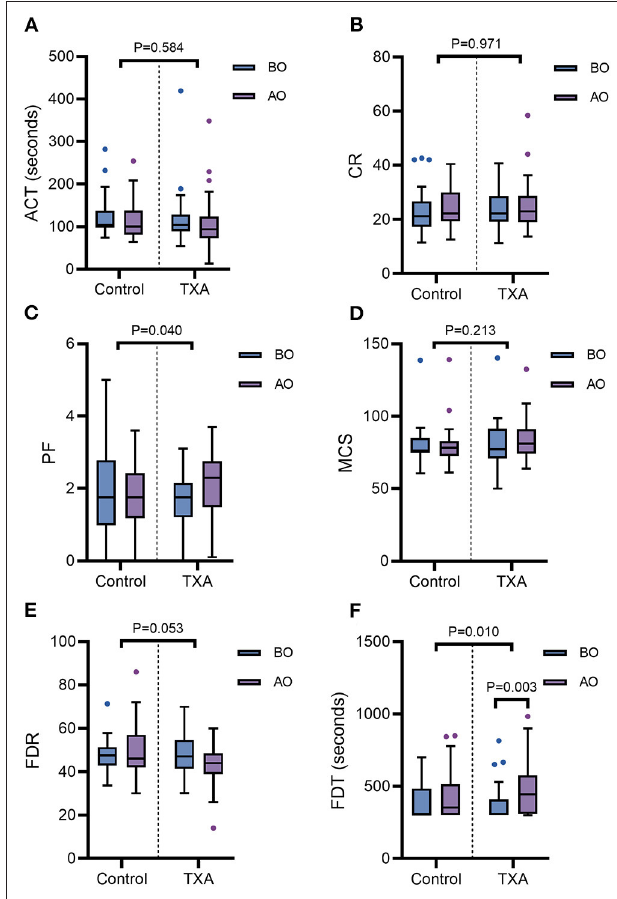
FIGURE 3 | The ACT-D (A) , CR-D (B) , PF-D (C) , MCS-D (D) , FDR-D (E) , and FDT-D (F) were compared by the Mann-Whitney U test for comparisons between the two groups. The line in the middle indicates the median value for each group, and the upper and lower bars represent the 25th and 75th percentiles, respectively. TXA, tranexamic acid; ACT, activated clotting time; CR, clot rate; PF, platelet function; MCS, maximal clot signal; FDT, fibrin degradation time; FDR, fibrin degradation rate; BO, before the operation; AO, after the